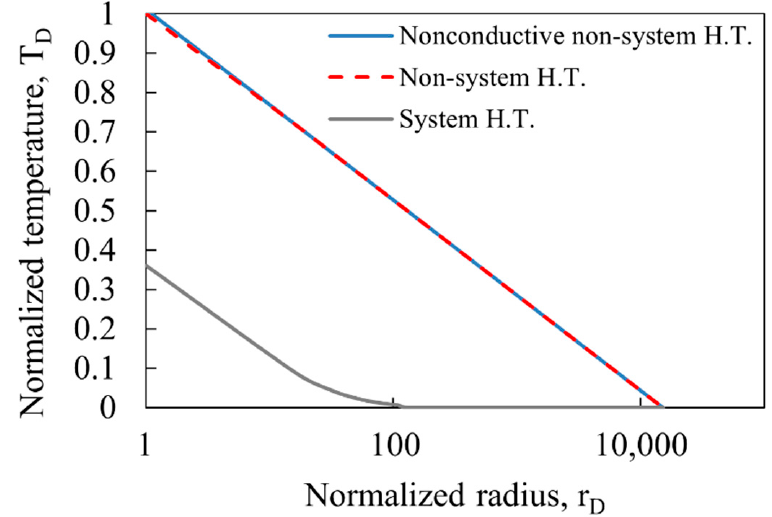
Figure 4. Comparison of the normalized radial temperature distribution among the three steady-state cases: the nonconductive non-system H.T. model, the non-system H.T. model, and the system H.T. model.